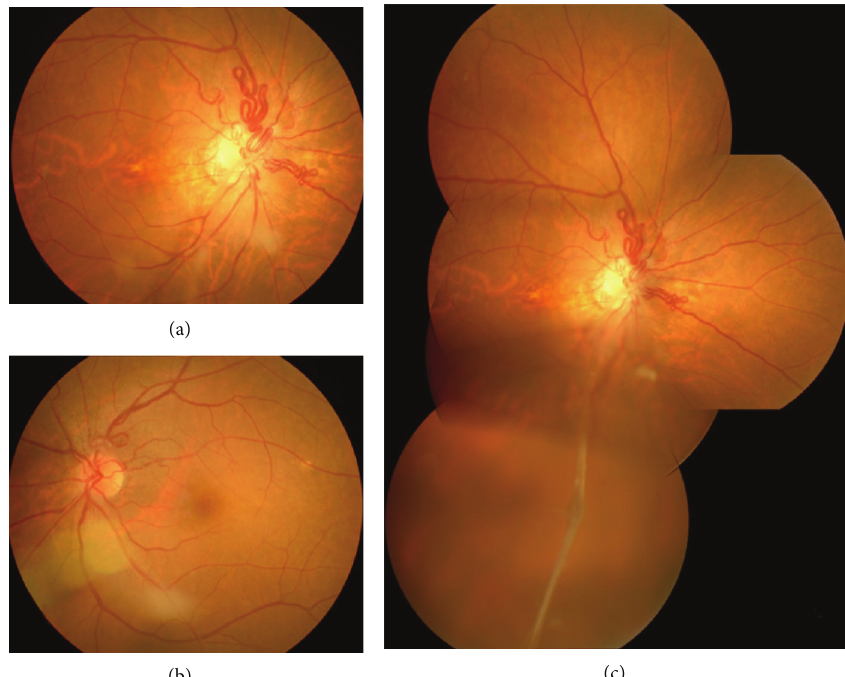
Figure 1: Fundus photographs showing a bilateral prepapillary vascular loop (a, b) and persistent hyperplastic primary vitreous in the right eye